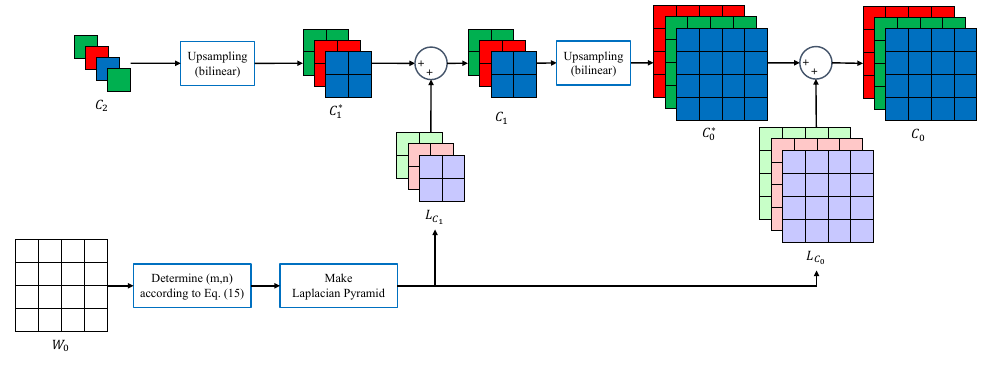
Figure 6. The proposed method for color channel interpolation using Laplacian pyramid